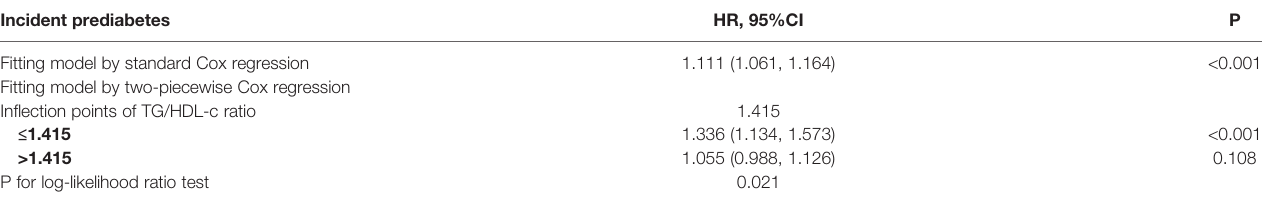
TABLE 6 | The result of the two-piecewise linear regression